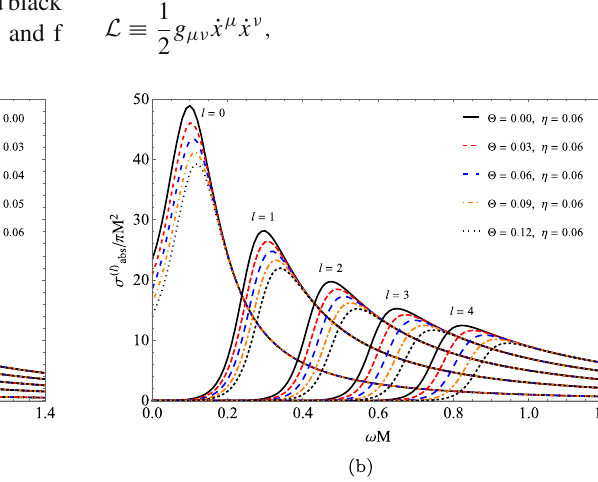
Fig. 5 Absorption cross section for l = 0 , 1 , 2 , 3 ,